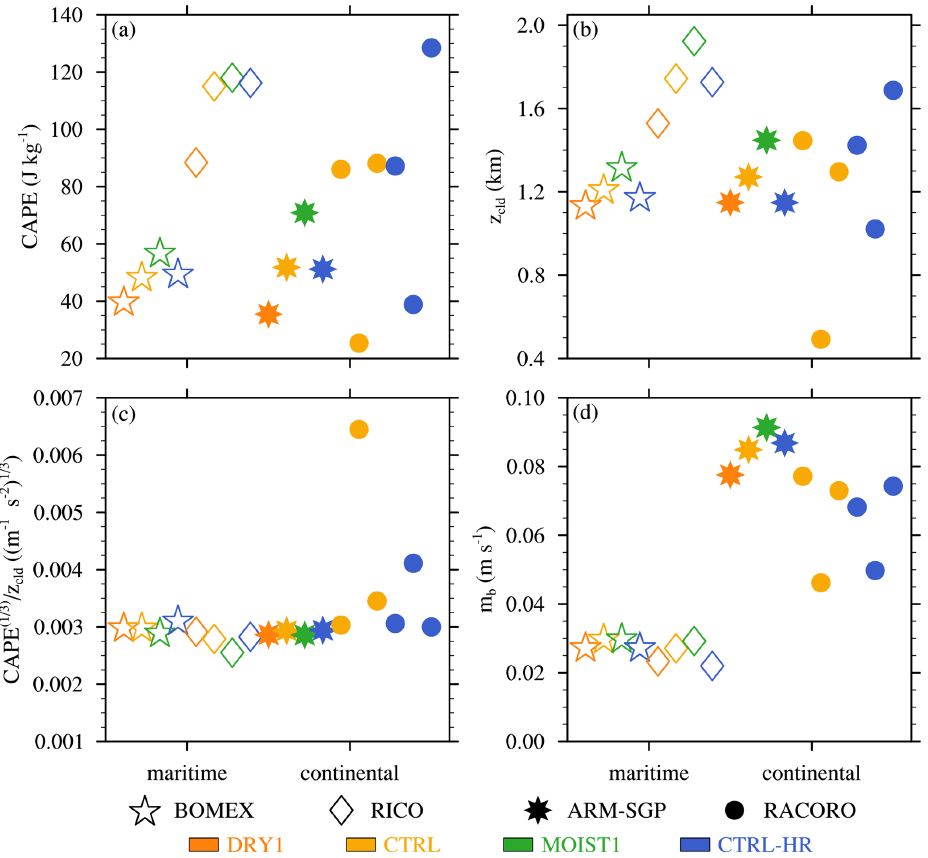
Figure 11. Analysis of the maritime and continental experiments: (a) convective potential available energy (CAPE), (b) cloud-layer depth ( z cld ), (c) CAPE ( 1 / 3 ) /z cld , and (d) cloud-base mass flux ( m b